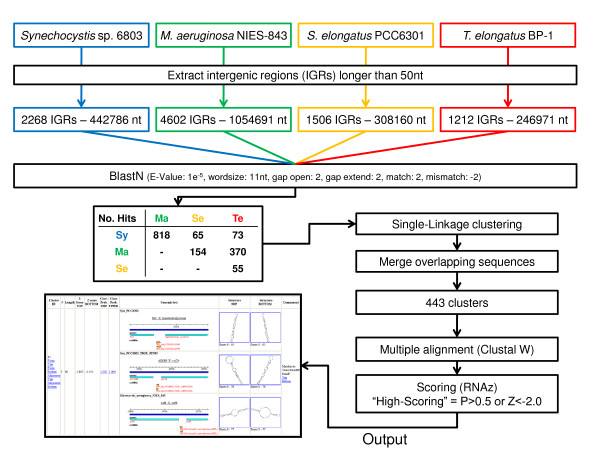
Pipeline for comparative prediction of RNA elements and ncRNAs. Intergenic sequences of at least 50 nt were gathered from four cyanobacterial genomes and locally aligned using BLASTN. Sequences which directly produced a significant blast hit (E-value < 10-5) or which were connected by a chain of such hits were gathered into clusters ("single-linkage clustering"). After an additional unification step of overlapping sequences within each cluster the resulting clusters and their complement clusters were scored using RNAz [26]. The inset shows how this information is provided in the internet, together with the location within the compared genomes, using the top-scoring cluster (CLID 80) as an example.